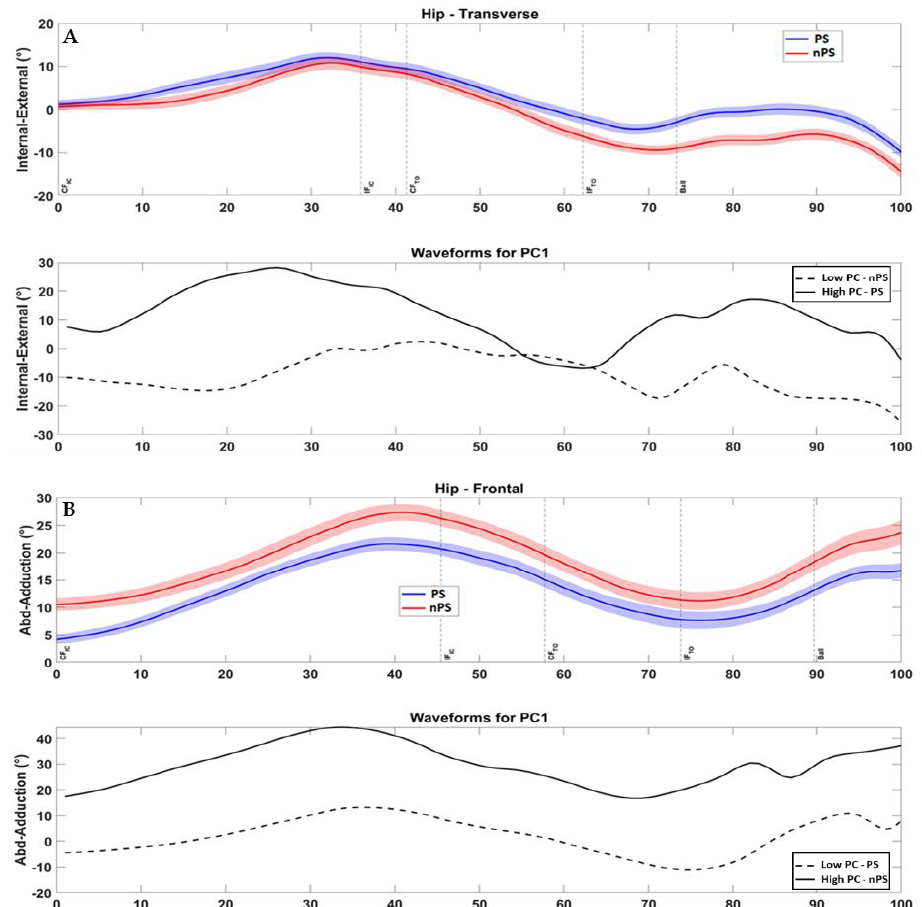
Figure 5. ( A ) High dive—Lower Limb, Ipsilateral—in the bottom row, preferred side waveform is represented by the high PC (solid line) for this kinematic variable; ( B ) Low dive—Lower Limb, Contralateral: in the bottom row, preferred side waveform is represented by the low PC (dashed line) for this kinematic variable. Note: PS = preferred diving side; nPS = non-preferred diving side; PC = principal component; IC = initial contact; TO = toe-off, CF = contralateral foot; IF = ipsilateral foot; Ball = ball contact.